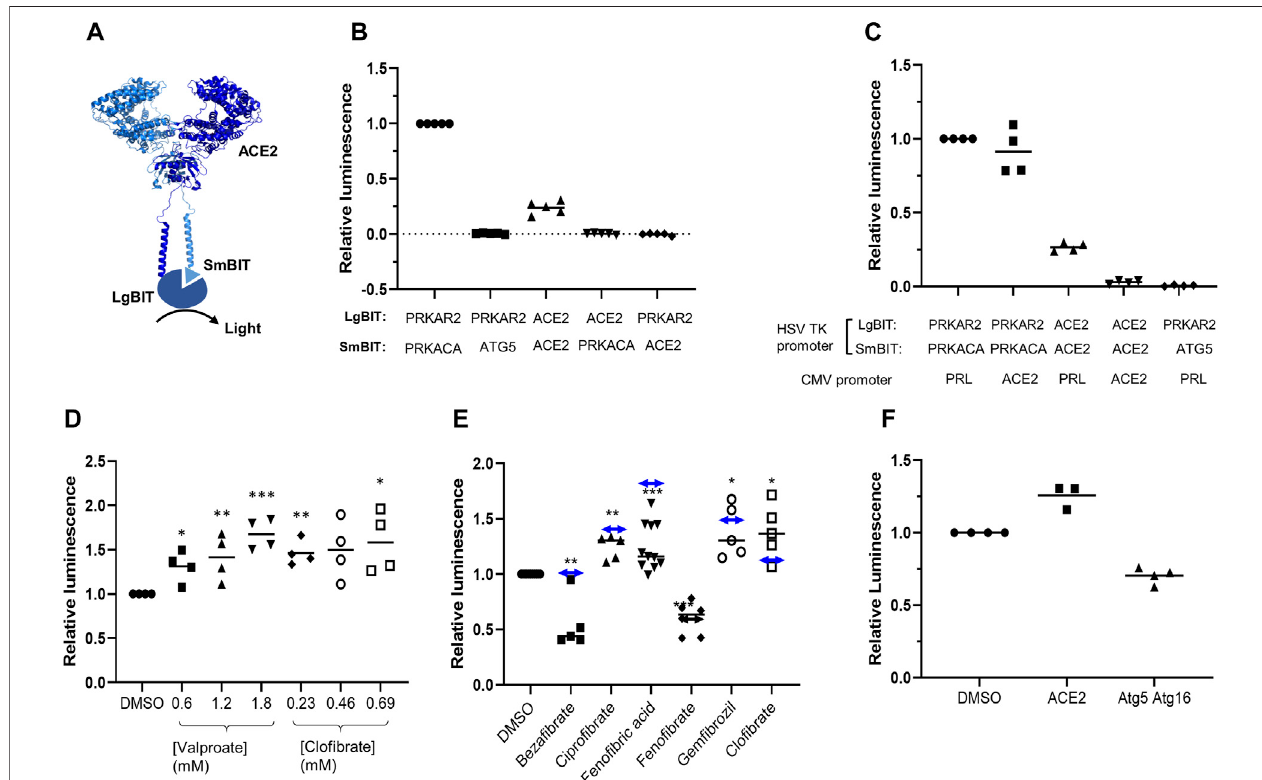
FIGURE 1 | ACE2 dimerization assay. A. Schematic showing ACE2 tagged with LgBIT and SmBIT. B. HEK-293 cells were transfected with combinations of plasmidsencodingLgBITorSmBITfusedtoeitherproteinkinaseAregulatorysubunit(PRKAR2)orcatalytic subunit(PRKACA),ATG5orACE2.Theresults(mean ± SD, n (cid:2) 5) were normalized to the luminescence measured in cells transfected with protein kinase A reporters (positive control). C. HEK-293 cells were transfected with plasmids encoding ACE2 NanoBIT reporters under the control of the HSV TK promoter and ACE2 or prolactin (PRL) under the control of the CMV promoter. The results (mean ± SD, n (cid:2) 4) were normalized to the luminescence measured in cells transfected with protein kinase A reporters and prolactin. D. HEK-293 cells were transfected with NanoBIT-tagged ACE2 reporters and incubated with sodium valproate or clo fi brate at a concentration equal to 1x, 2x, or 3x the reported C max of the drug. After 1 h, luminescence was measured and normalized (mean ± SD, n (cid:2) 4) to that measured in cells treated with DMSO. E. A series of other fi brates were similarly evaluated in the assay. The luminescence measured (mean ± SD, n (cid:2) 5 – 11) was signi fi cantly different to that measured in cells treated with solvent where shown (* p < 0.05; ** p < 0.01; *** p < 0.005). When these fi brates were incubated with puri fi ed LgBIT and HiBIT-RBD to create a constitutively active NanoLuc, each of these fi brates was found to inhibit nanoluciferase (beza fi brate 35 ± 7%, cipro fi brate 55 ± 6%, feno fi bric acid 48 ± 7%, feno fi brate 69 ± 5%, and gem fi brozil 61 ± 2% of the activity measured in the presence of DMSO). To correct this, the luminescence measurements from cells treated with fi brates in cells were divided by the fractional inhibition noted above to estimate the effect of the drugs on dimerization. These corrected results are shown as a horizontal line with double-headed arrows. F. HEK293 cells expressing either NanoBIT-tagged ACE2 or a combination of Atg5-SmBIT and Atg16-LgBIT were incubated with feno fi bric acid (230 µM) and luminescence measured (mean ± SD, n (cid:2) 4).